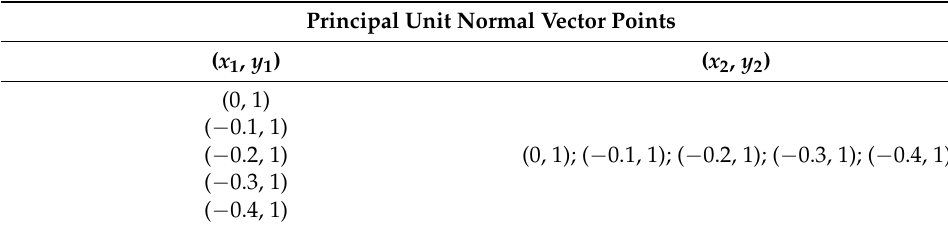
Table 1. Values of unit normal vector points for various profiling options.